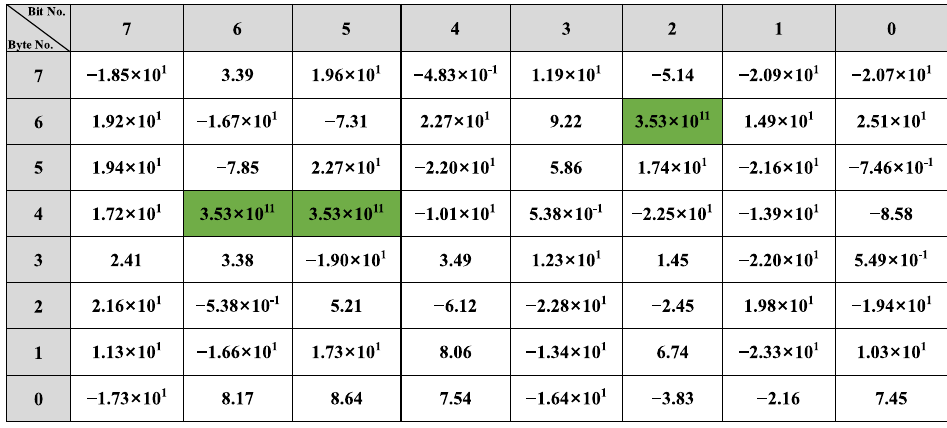
Figure 17. Wiper-related messages reverse result. Table 5. Results for gears and wipers of bit-level reverse.